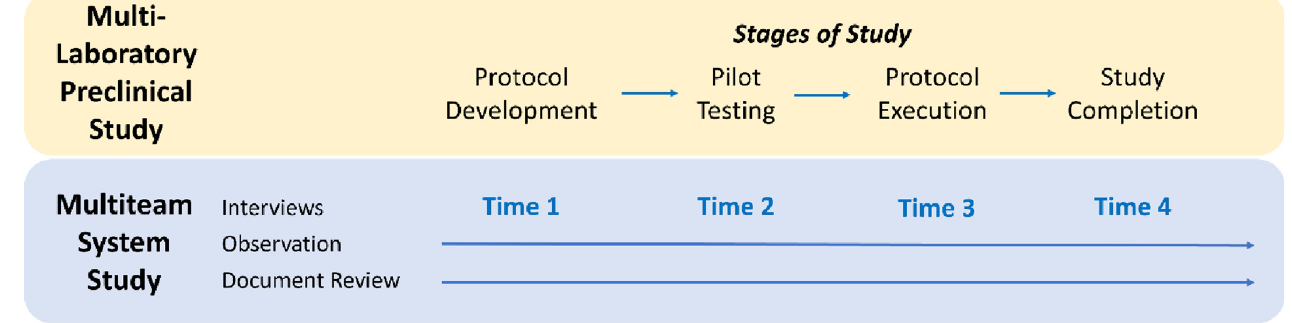
Fig 1. Longitudinal data collection